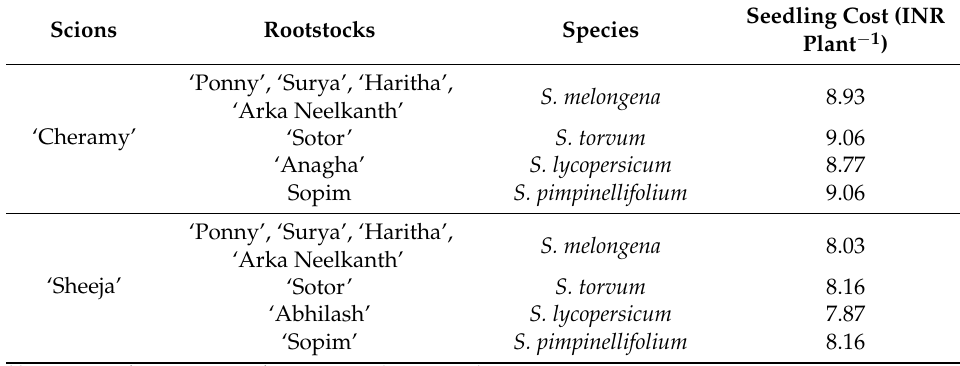
Table 8. Cost of grafted seedlings in different graft combination.